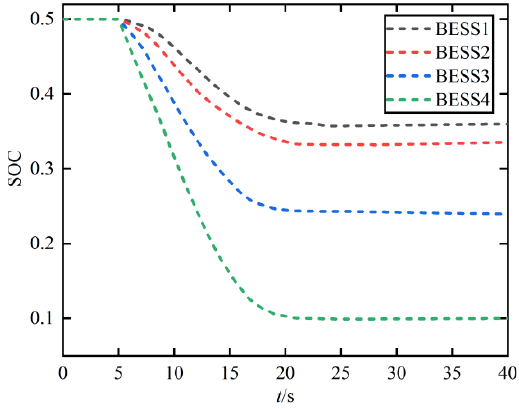
Figure 13. SOC of the BESS based on power ratio.